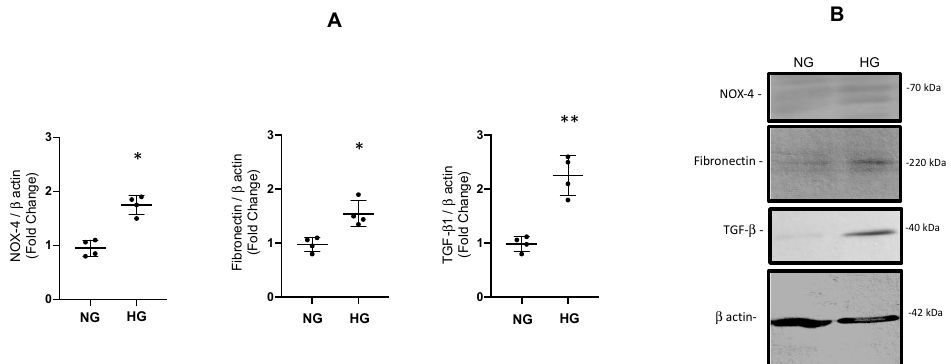
Figure 7. ( A ). Protein abundances of fibronectin, TGF- β 1 1 and NOX-4 after 48 h of high glucose conditions (HG) vs. normal glucose (NG) assessed by immunoblot in IMCD cells. * p < 0.05 vs. control group, ** p < 0.01 vs. control group n = 4. ( B ). Representative blot for each protein analyzed. The β -actin was used as loading control. Next, we performed immunofluorescence studies on IMCD cells using fibronectin, TGF- β 1, and NOX-4 antibodies. IMCD cells showed a basal expression of fibronectin that was augmented after 48 h of HG. The TGF- β 1 antibody did not show specific immunofluorescence labeling in IMCD cells. NOX-4 labeling intensity was present both at baseline and after 48 h of HG, as observed in Figure 8.